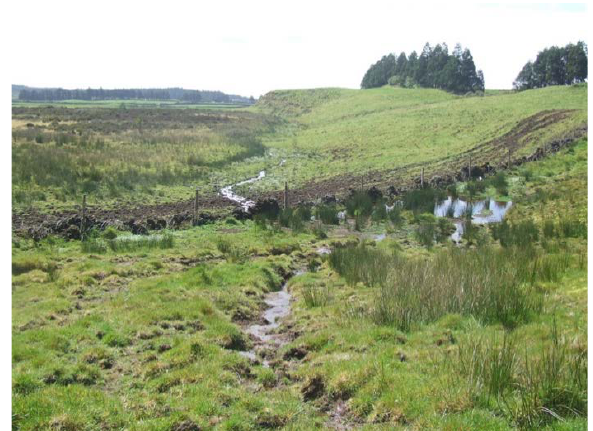
Figure 7. Part of the Criação do Filipe peatland complex showing evidence of disturbance caused by animal trampling as well as by the passage of vehicles including vans and tractors. Some clearly apparent consequences are vegetation change, alteration of the pattern of water movement, and peat